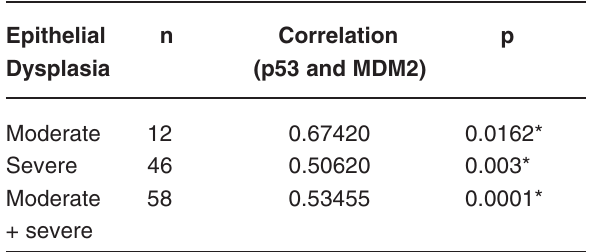
TABLE 1- Correlation between p53 and MDM2 proteins in severe and moderate epithelial dysplasia